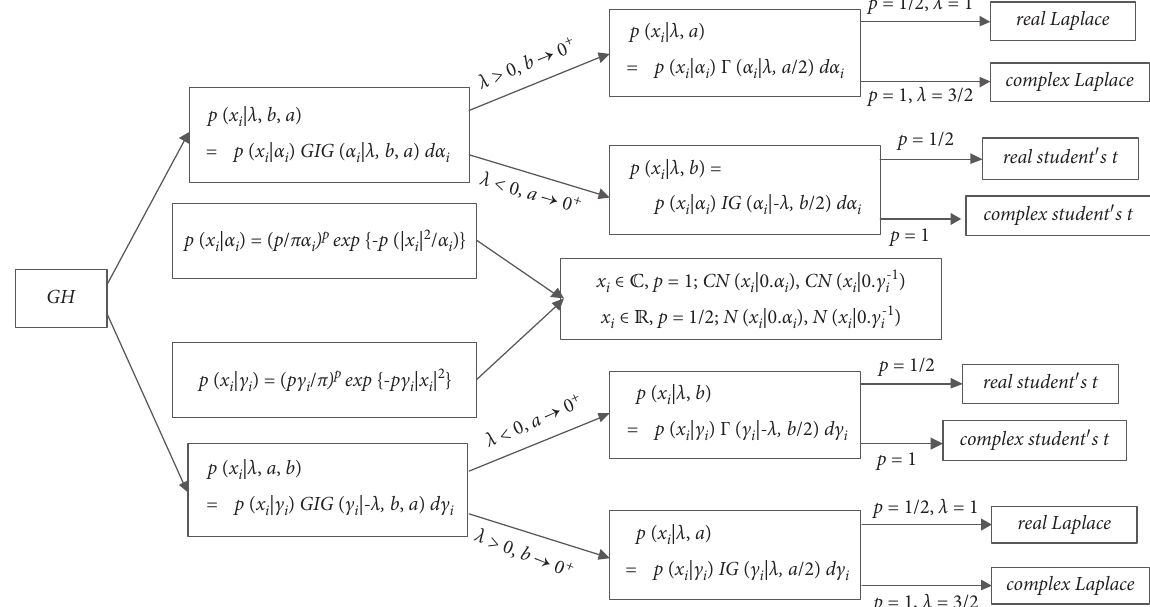
Figure 2: The relationship between different two-layer hierarchical